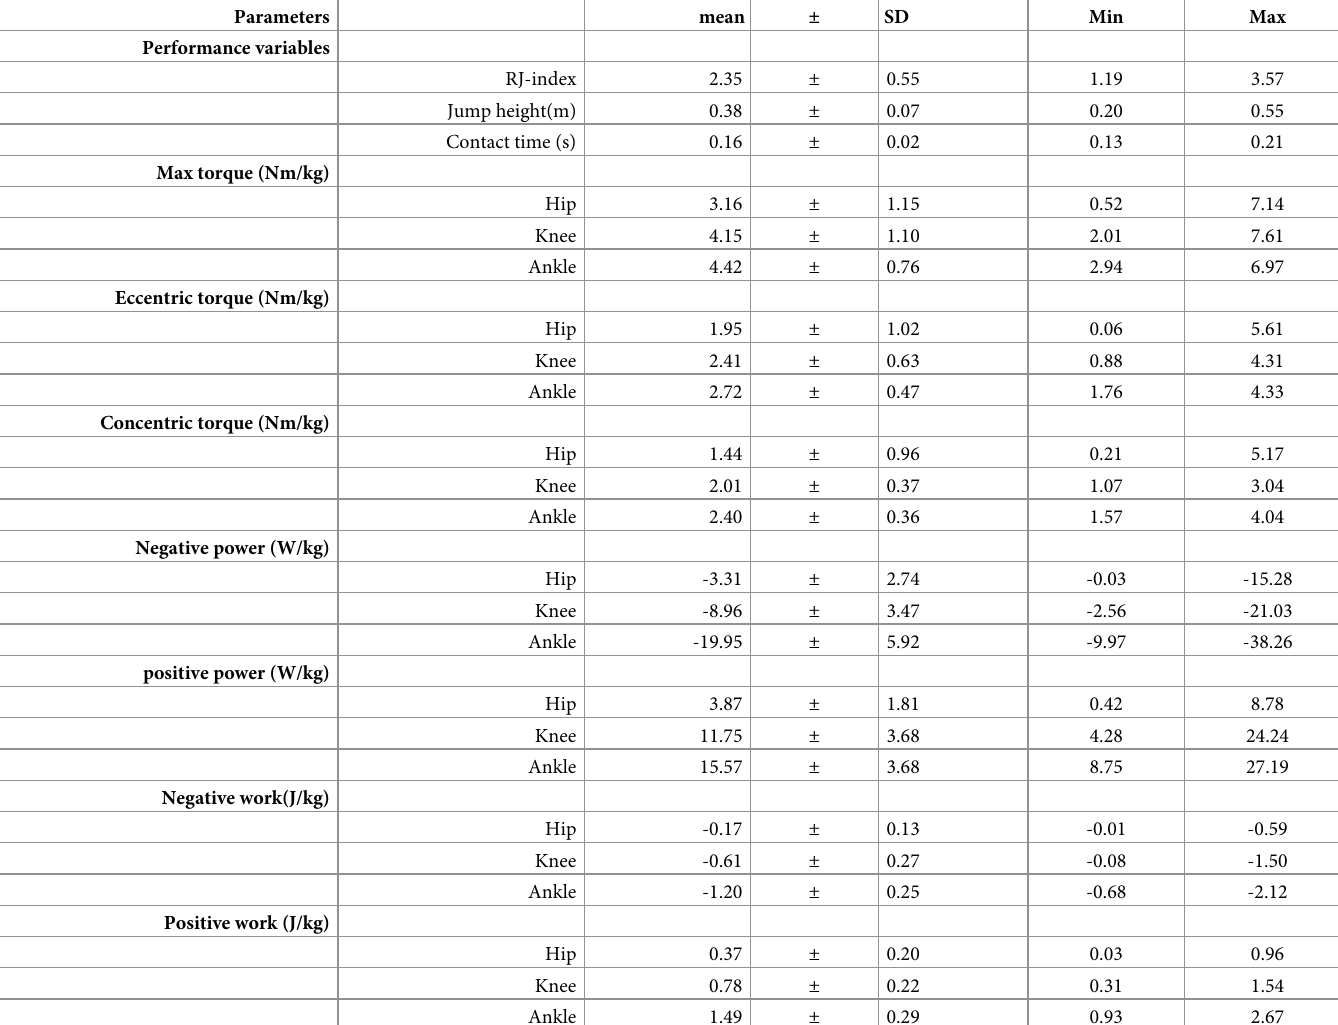
Table 1. Parameters of rebound jump